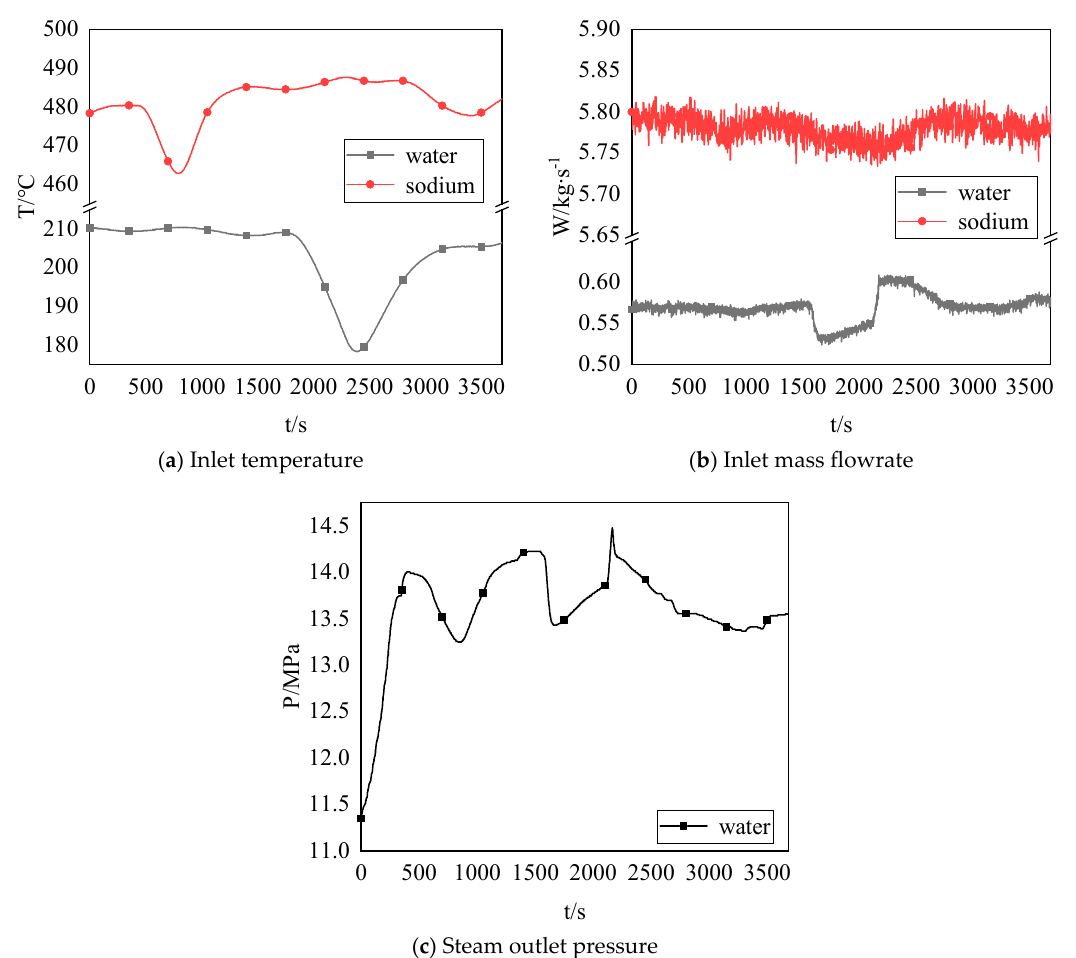
Figure 8. Multi − parameter change transient input boundary condition.